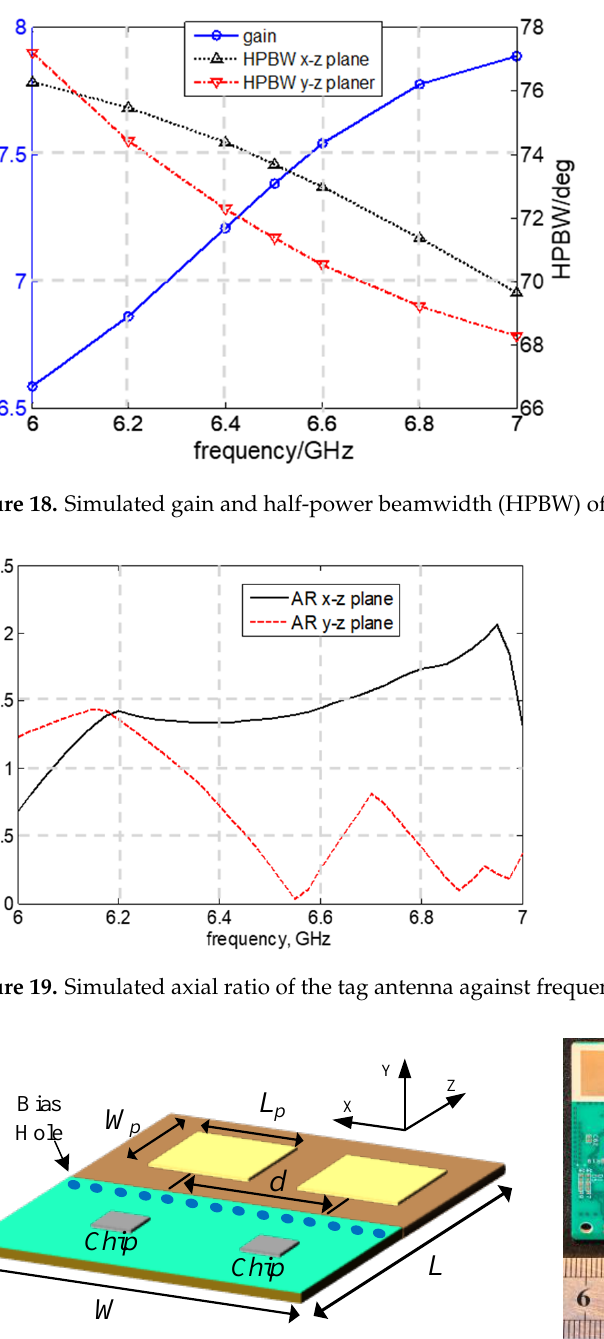
Figure 21. Simulated S parameters and HPBW of the anchor antennas as a function of frequency. ( a ) ( b ) ( c ) ( d ) Figure 22. Simulated radiation pattern of the anchor antenna. ( a ) 6.3 GHz. ( b ) 6.4 GHz. ( c ) 6.5 GHz. ( d ) 6.6 GHz.